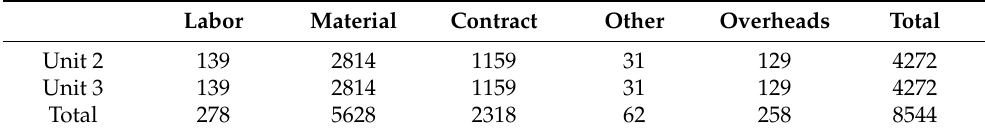
Table 4. Estimated installation costs for